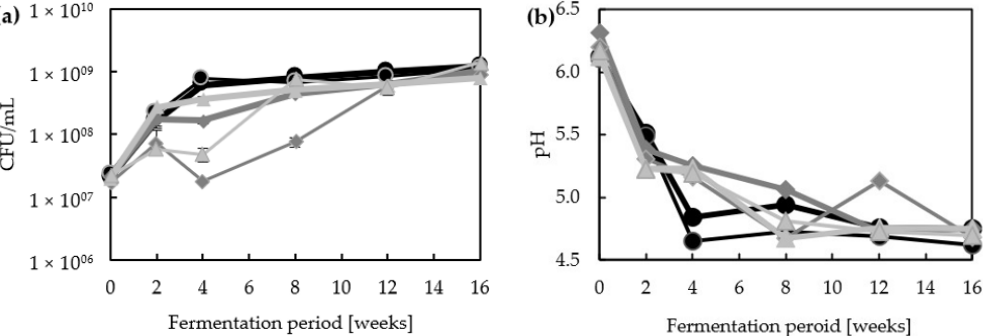
Figure 1. Abundance of microorganisms after four days of incubation on ME agar at 30 °C ( a ) and pH values ( b ) during moromi fermentation. Koji was prepared using lupine seeds with additional roasted lupine seeds (ML1 and ML2, circles, black), wheat (MW1 and MW2, squares, dark grey), or buckwheat (MB1 and MB2, triangles, light grey). The replicates could be distinguished by a grey border (ML2, MW2, MB2). Error bars indicate the standard deviation from quadruplicates.